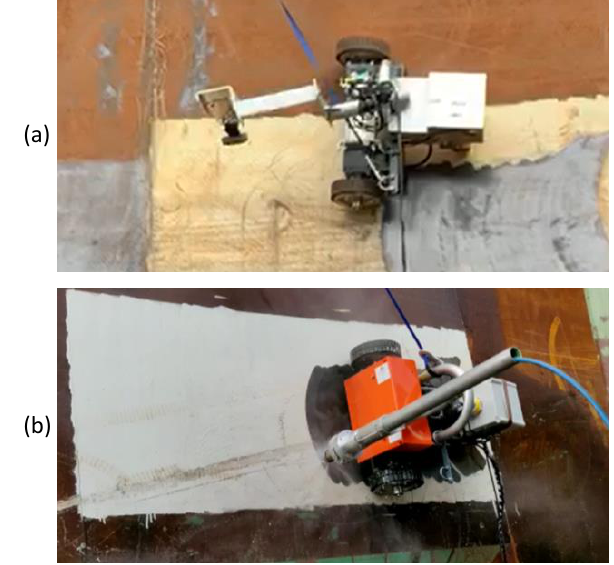
Figure 7. ( a ) Hornbbill is used as the bechmarking robot; ( b ) Hornbill is performing hydro